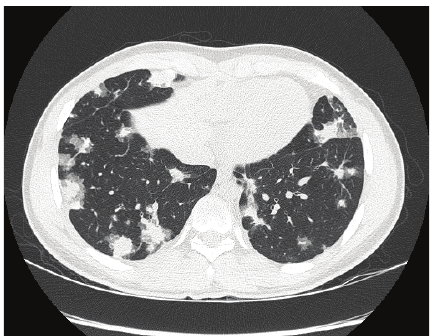
Figure 1: Chest computerized tomography scan. Multiple irregular ground glass nodules 2-3cm in diameter, mild thickening of airway walls, no effusion, and reactive lymphadenopathy in the perihilar regions